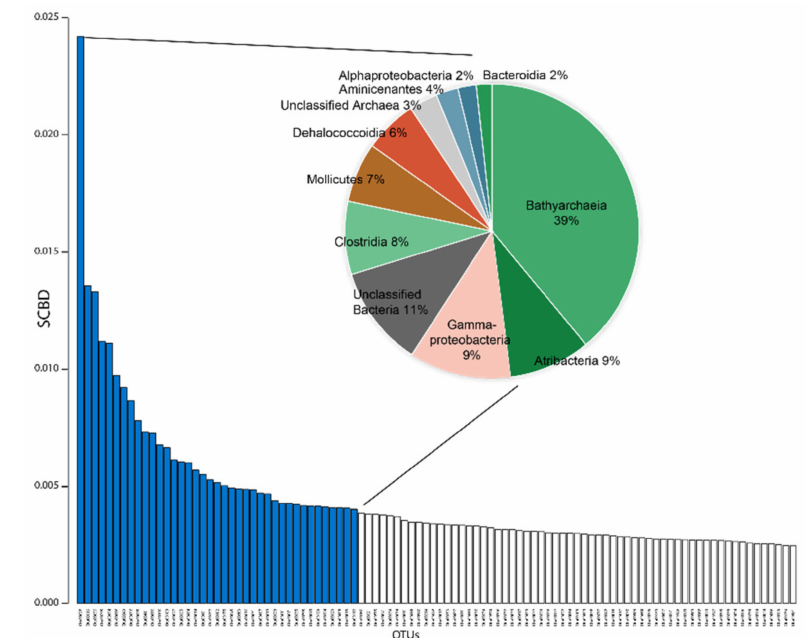
Figure 7. Species contribution to beta-diversity (SCBD) per OTU, and contribution and taxonomic assignment of the 40 first OTUs. Colors are the same as those used in Figure